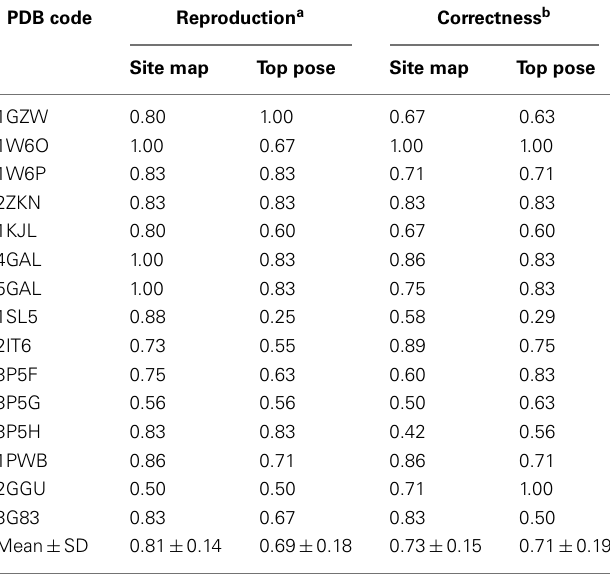
Table 3 | Site mapping results for carbohydrate–lectin interactions.